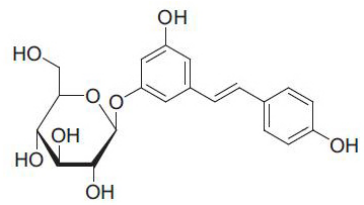
Figure 1. Chemical structure of polydatin (3,4',5-trihydroxystilbene-3- β -mono- D -glucoside).